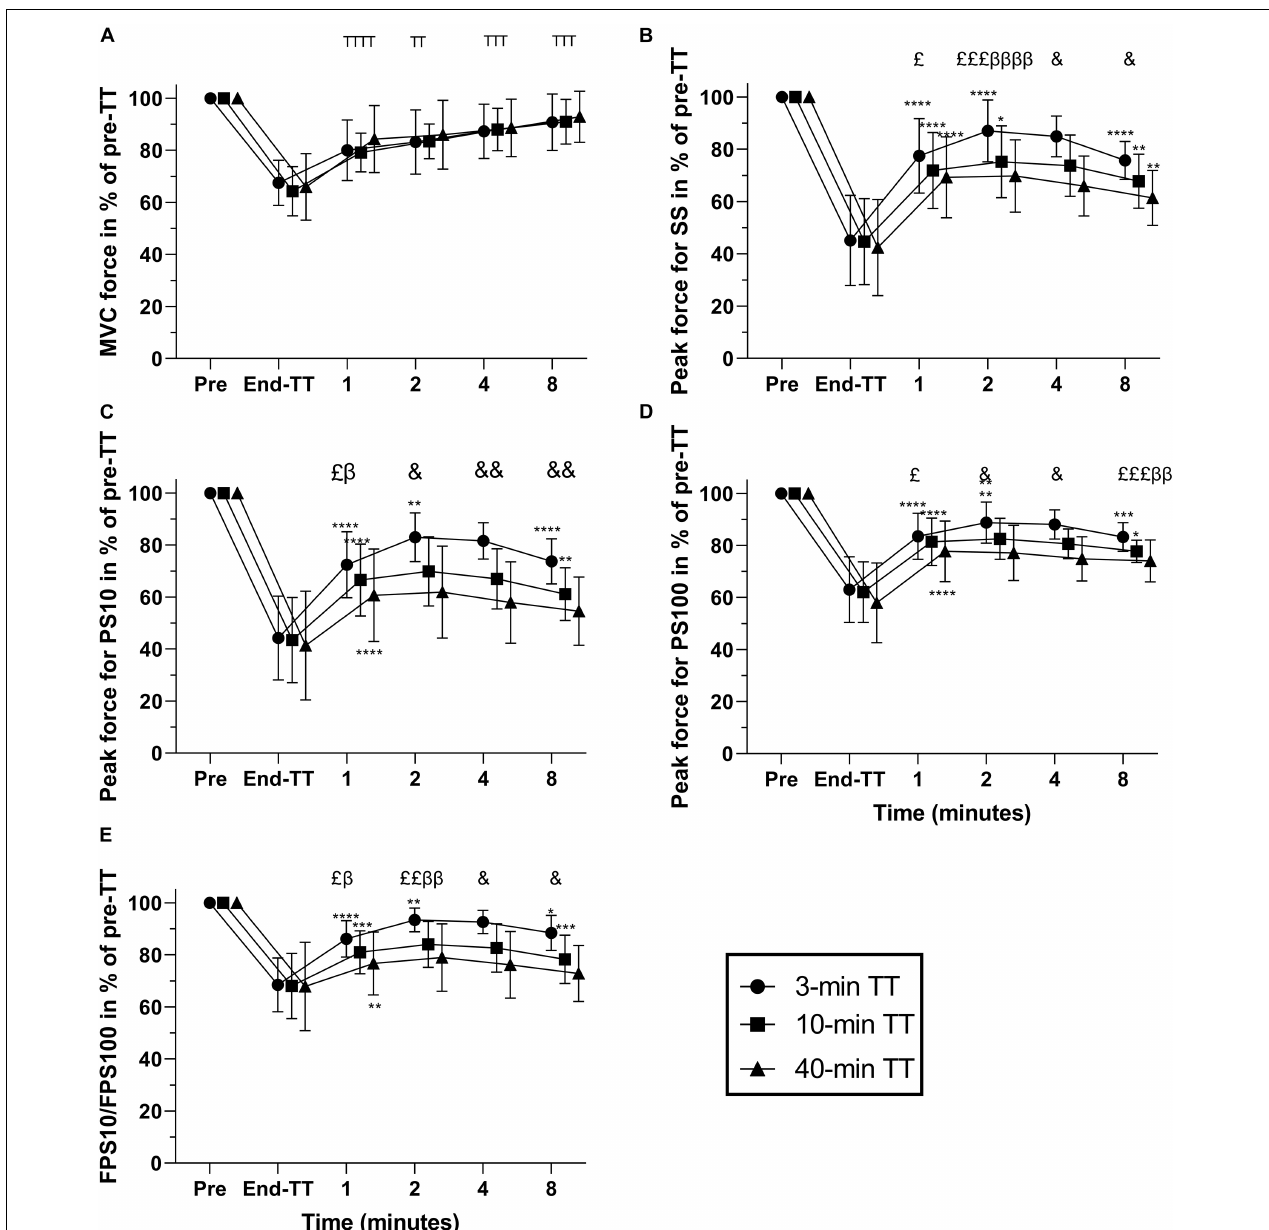
FIGURE 3 | Responses in% of pre-TT for 3, 10, and 40 min duration TTs pre-TT; at the end of TT; and during the first 1, 2, 4, and 8 min following exercise cessation. MVC (maximal voluntary contraction) force (A) , peak force for SS (single stimulus) (B) , peak force for PS10 (paired stimuli at 10 Hz) (C) , peak force for PS100 (paired stimuli at 10 Hz) (D) , and FPS10/FPS100 (force for paired stimuli at 10 Hz divided by that for 100 Hz) (E) . Data are shown as means ± SD, n = 12. T Significant difference from previous, main effect of time. *Significant difference from previous. β Significant difference between 3 min TT and 10-min TT. £ Significant difference between 3 min TT and 40 min TT. & Significant difference between all TTs’ β , P < 0.05. The number of symbols indicate significance at * P < 0.05; ** P < 0.01; *** P < 0.001; and **** P < 0.0001. Numerical data for these parameters is provided in Supplementary Table S1 . TT, time